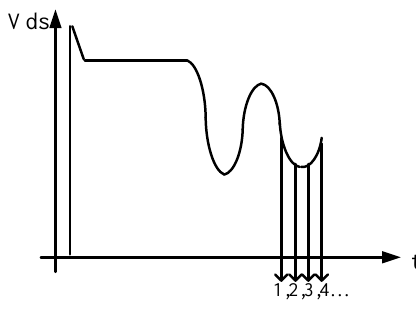
Figure 7. Change in quasi-resonant detection (QRD) delay signals.